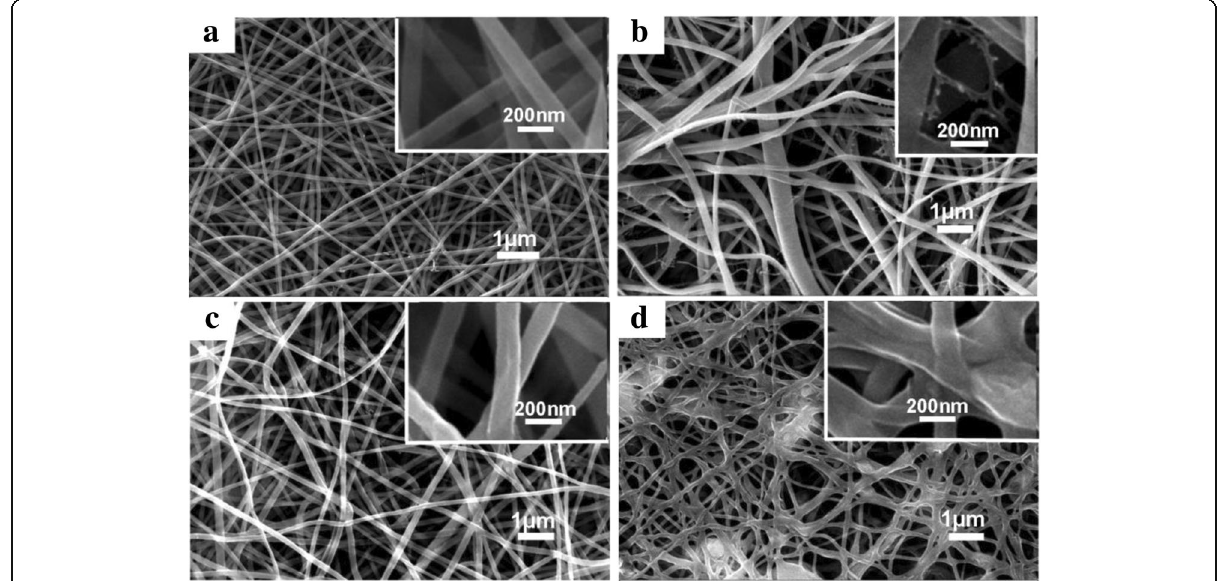
Fig. 5 SEM images of a pure PA66 NFM, b PA66/CoCl 2 ·6H 2 O (10 wt%) NFM, c PA66/CoCl 2 ·6H 2 O (30 wt%) NFM, and d PA66/CoCl 2 ·6H 2 O (50 wt%)